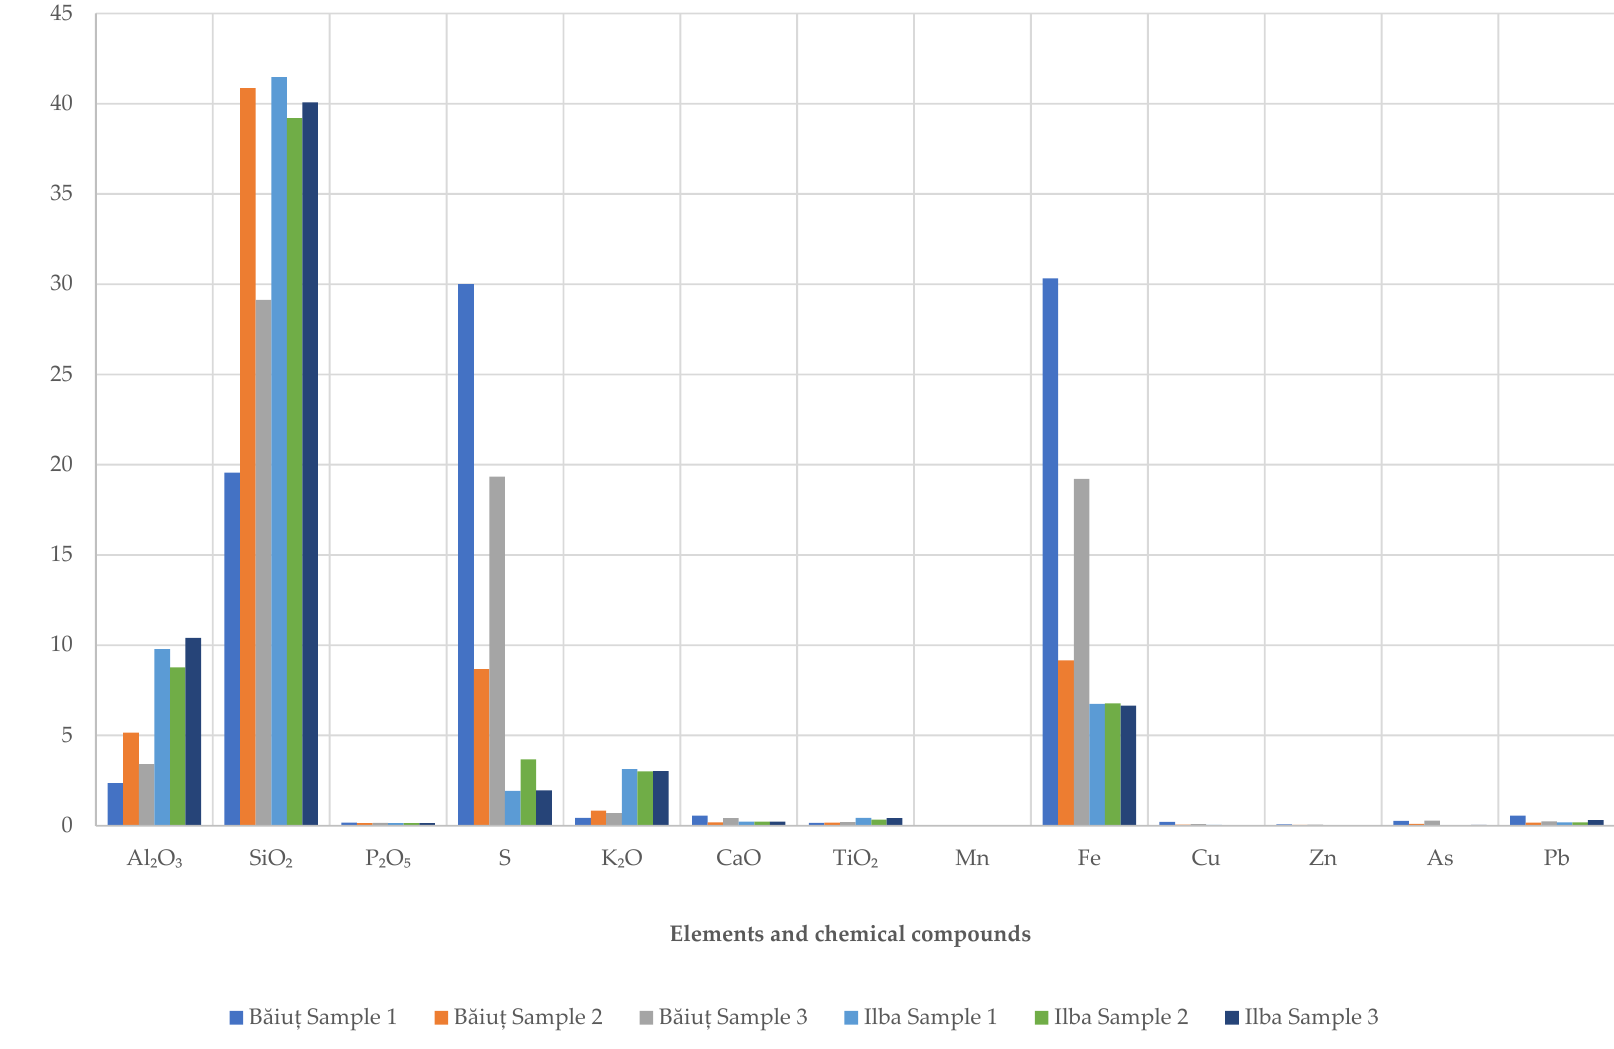
Figure 13. Mean chemical compositions of samples from the sterile mining dumps, based on p − XRF measurements.